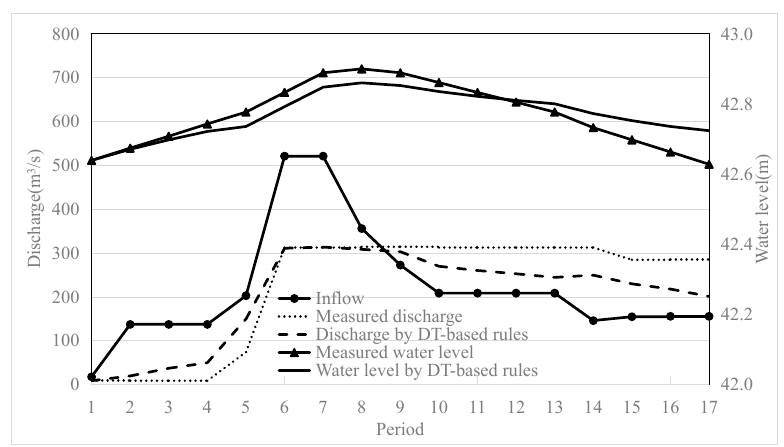
Figure 5. Operation hydrographs for 13 Aug 2021.